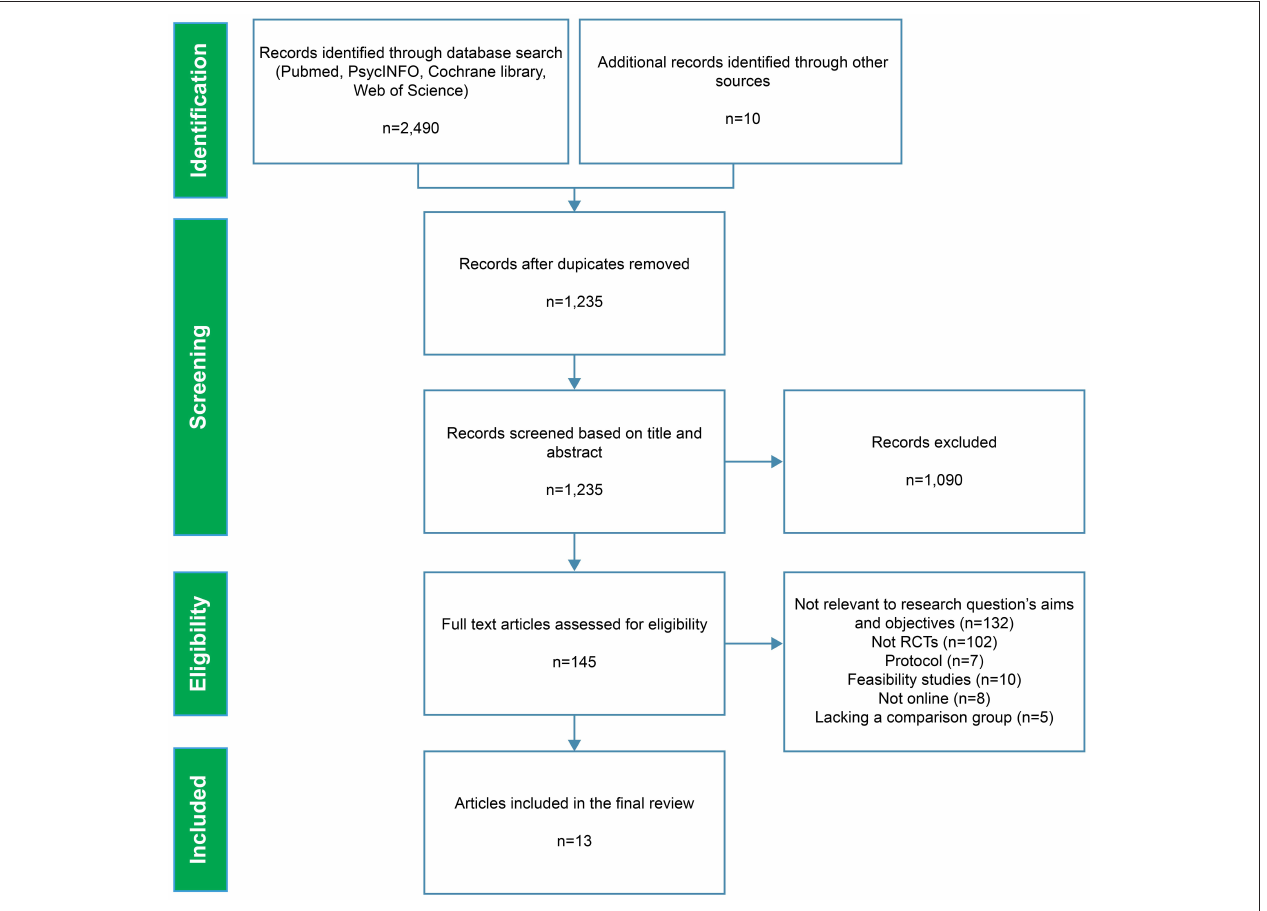
FIGURE 1 | PRISMA flow